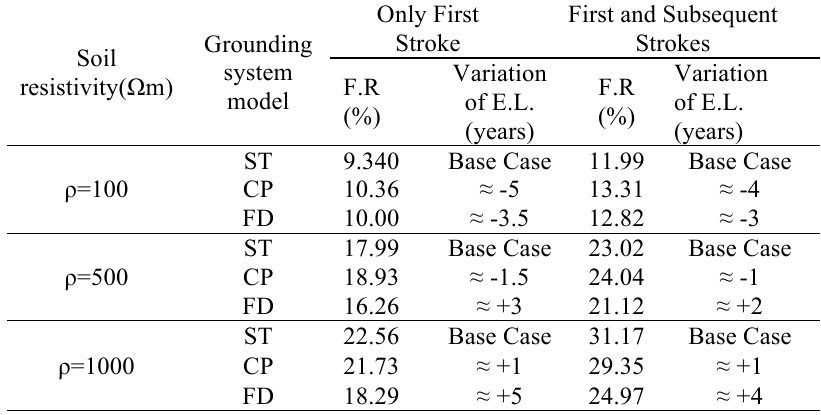
Grounding System, (N =5). g